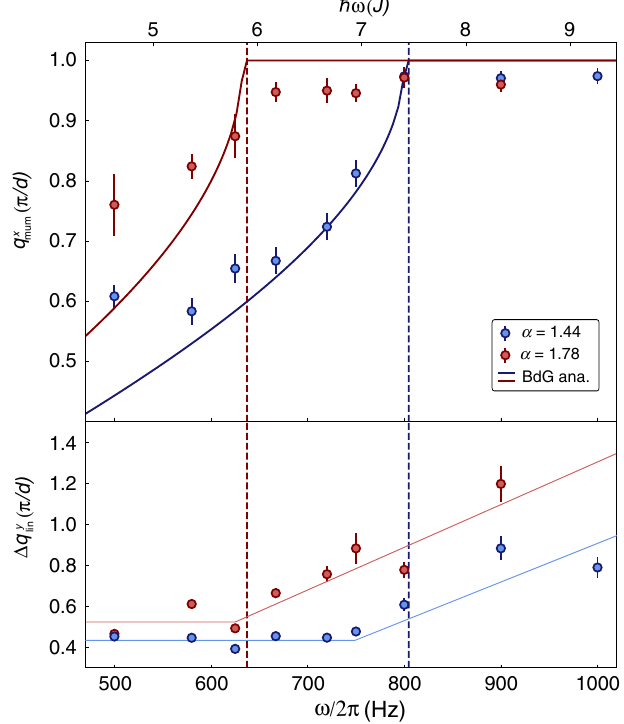
FIG. 4. Position of the most unstable mode and influence of transverse modes. Upper panel: Position of the most unstable mode q x as a function of modulation frequency for α ¼ 1 . 44 mum and α ¼ 1 . 78 . The error bars denote the standard error of the mean. The solid lines show Eq. (3) for g ¼ 11 . 5 J . The vertical dashed lines mark the corresponding saturation frequency. Lower ð ω Þ . Error bars denote the standard panel: Transverse width Δ q y lin error of the weighted mean. The thin lines are guides to the